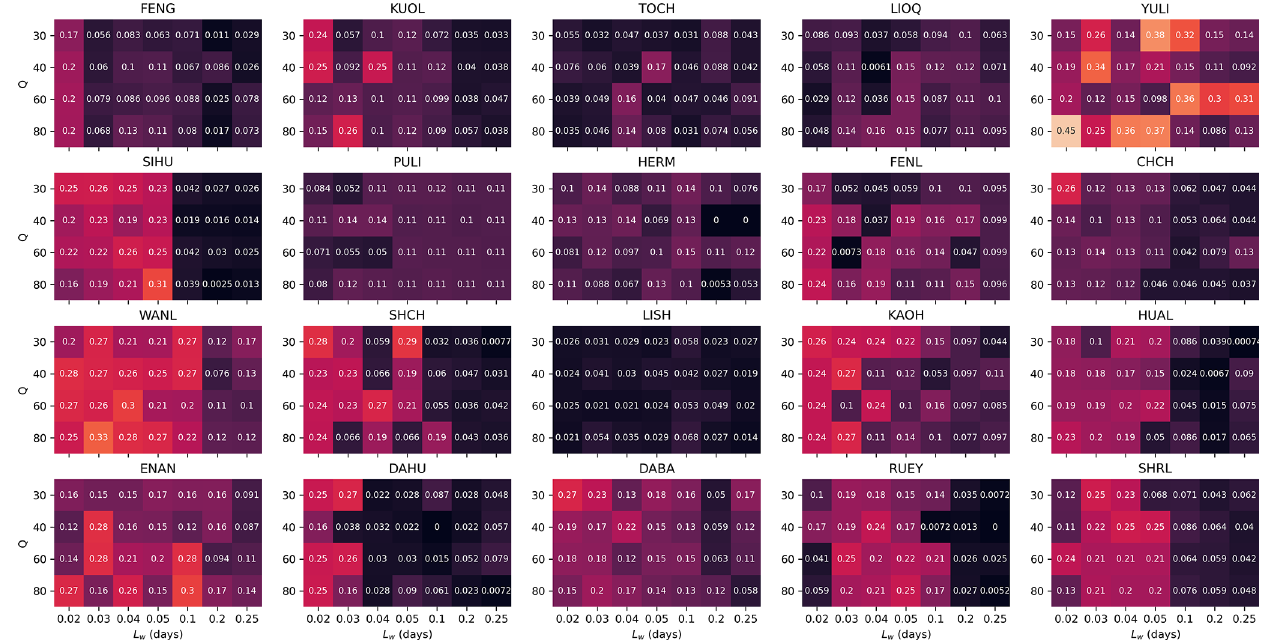
Figure 13. Heatmaps of R EQS values for all 20 stations across tested hyperparameter space, given R D _min = 0 . 95.